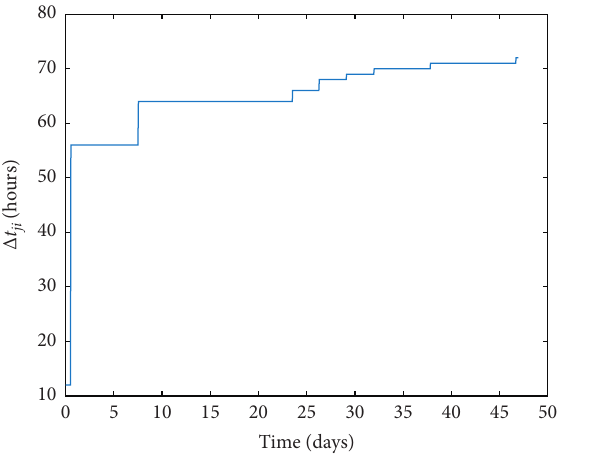
Figure 16: Evolution of Δ t .